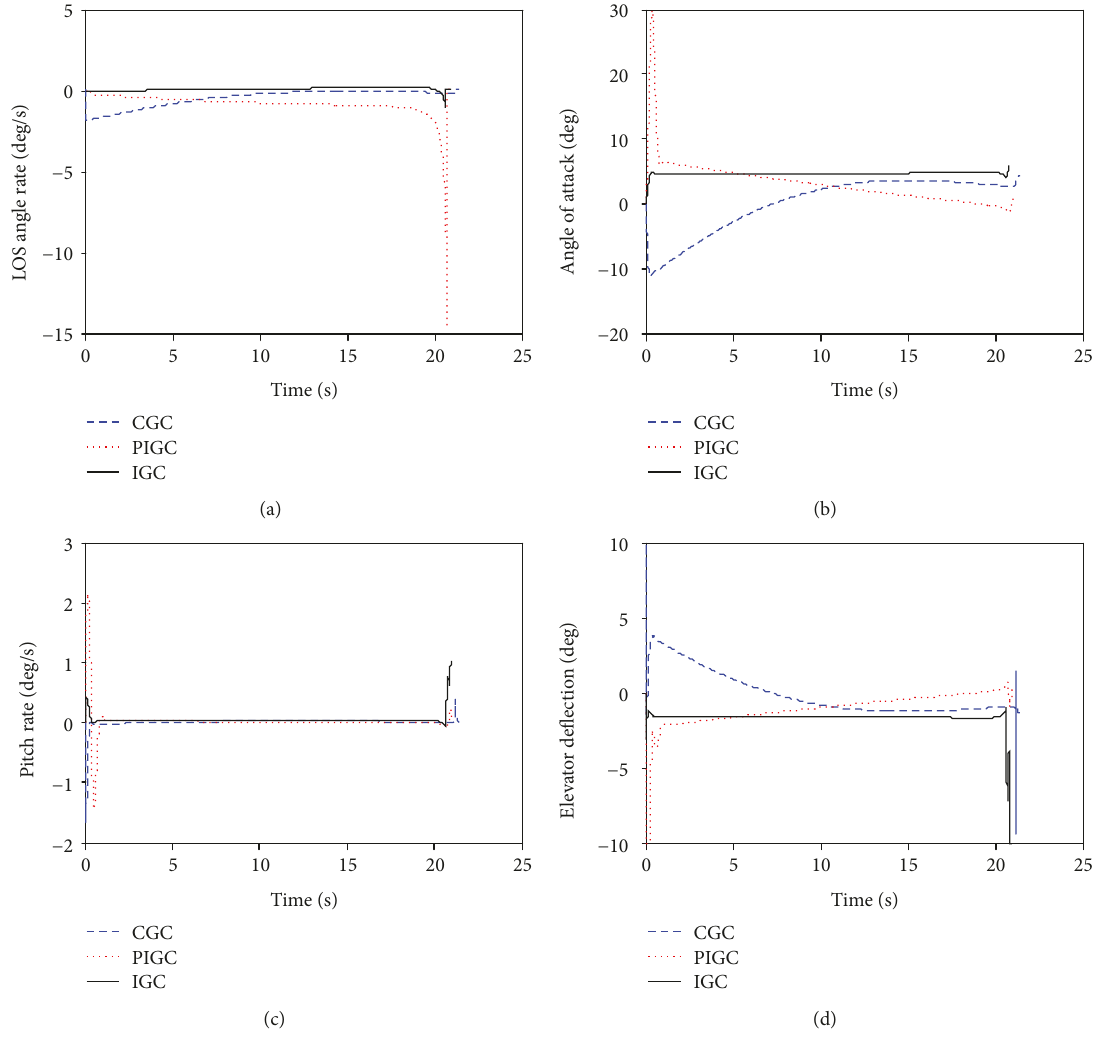
Figure 6: Variable response curves under the three control laws against a maneuvering target. Table 5: Miss distance under the three control laws against a maneuvering target.